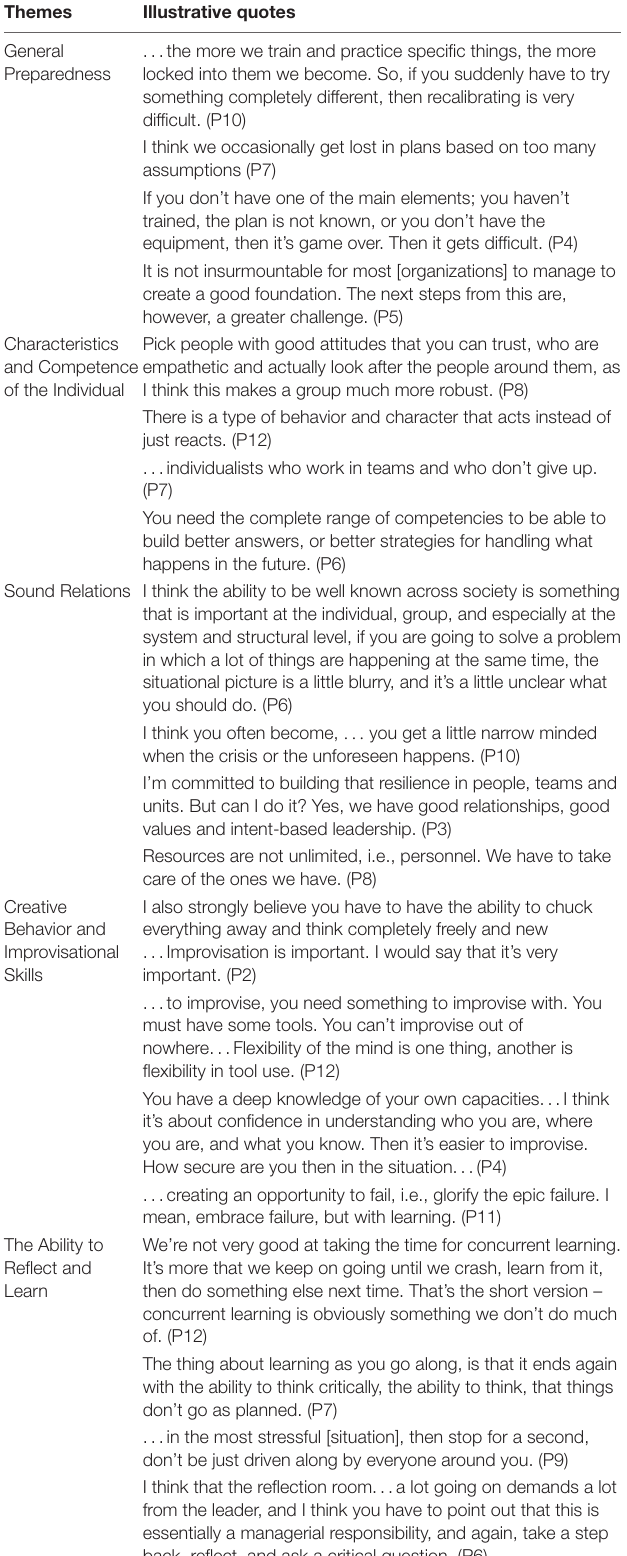
TABLE 4 | Quotes from experts illustrating five themes related to competence for the